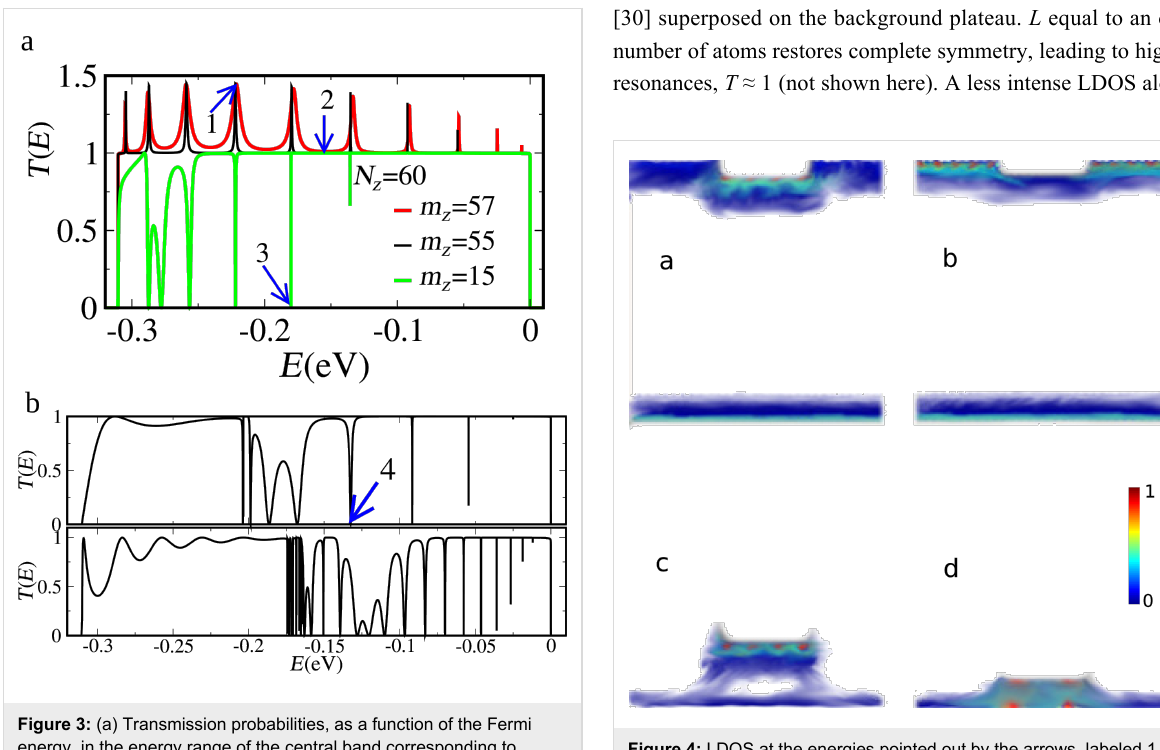
Figure 4: LDOS at the energies pointed out by the arrows, labeled 1, 2, 3 and 4, in Figure 3 for L = 10. The upper panel is for shallow constrictions, N Z = 60 and m Z = 57: (a) at resonant energy, corre- sponding to arrow (b); at off-resonant energy, corresponding to arrow 2. The lower panels are for deep constrictions: (c) at the anti-reso- nance indicated by arrow 3 ( m Z = 15); (d) at the anti-resonance high- lighted by arrow 4 ( m Z =